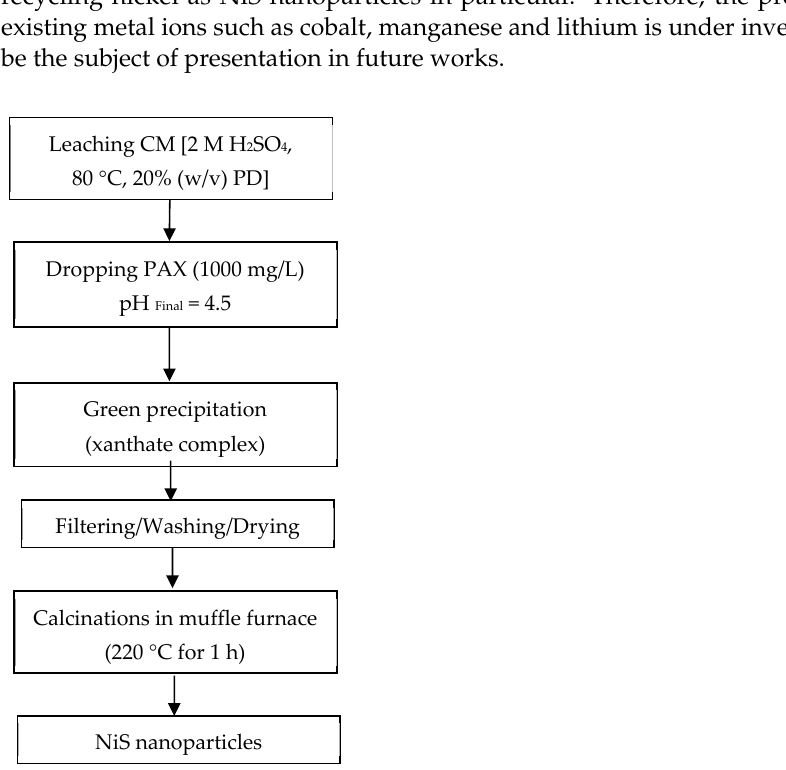
Figure 1. A demonstration of an experimental flow diagram for fabricating nanoparticles from the spent LIBs.